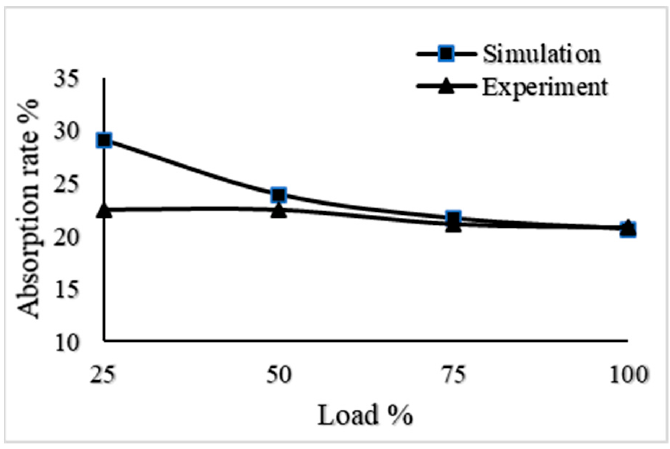
Figure 9. The CO 2 absorption rate of the experiment compared with the simulation.